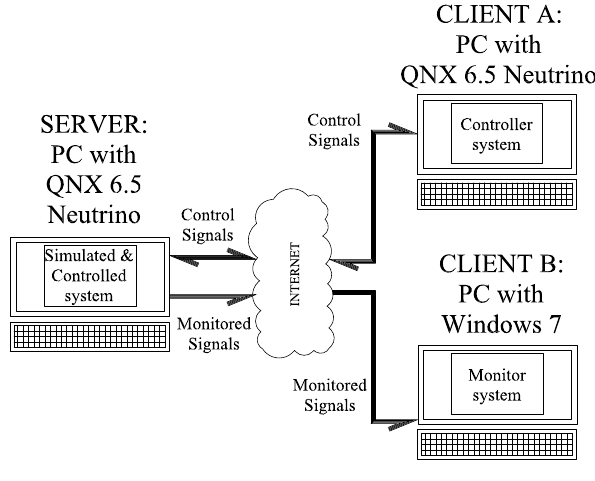
Figure 1. Proposed telecontrol